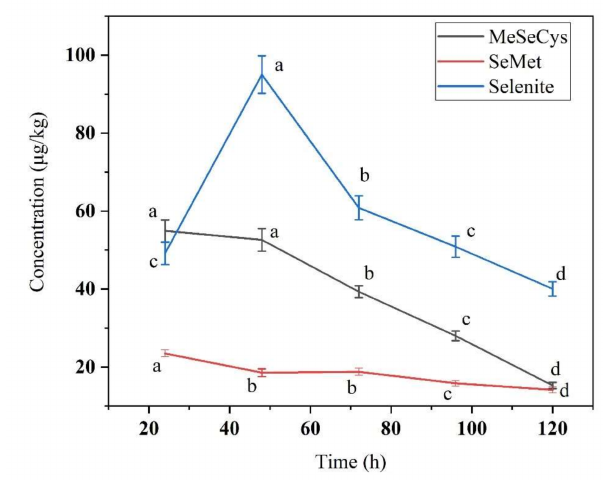
Figure 4. Concentration of three kinds free Se species during soybean germination under 20 mg/L sodium selenite solution. Different letters are used to show significant differences at various treat- ments ( p < 0.05) in the same Se species.